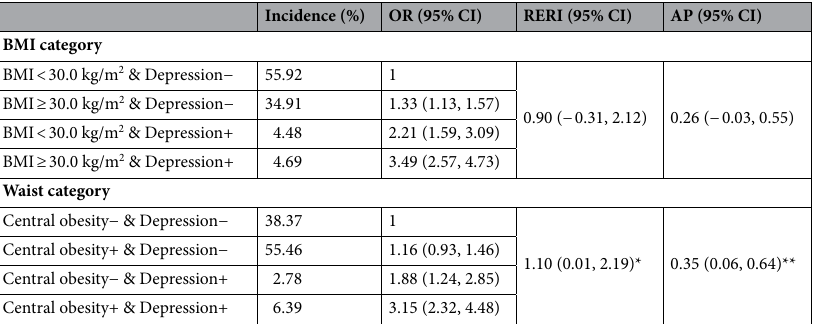
Table 2. Synergic effect of depression and obesity on ischemic heart disease incidence, NHANES 2007–2018 ( N = 29,050). The model adjusted for age, gender, ethical groups, educational level, household income, caffeine intake, total energy intake, smoking, alcohol consumption, work activity, recreational activity diabetes and hypertension. *P < 0.05. **P <